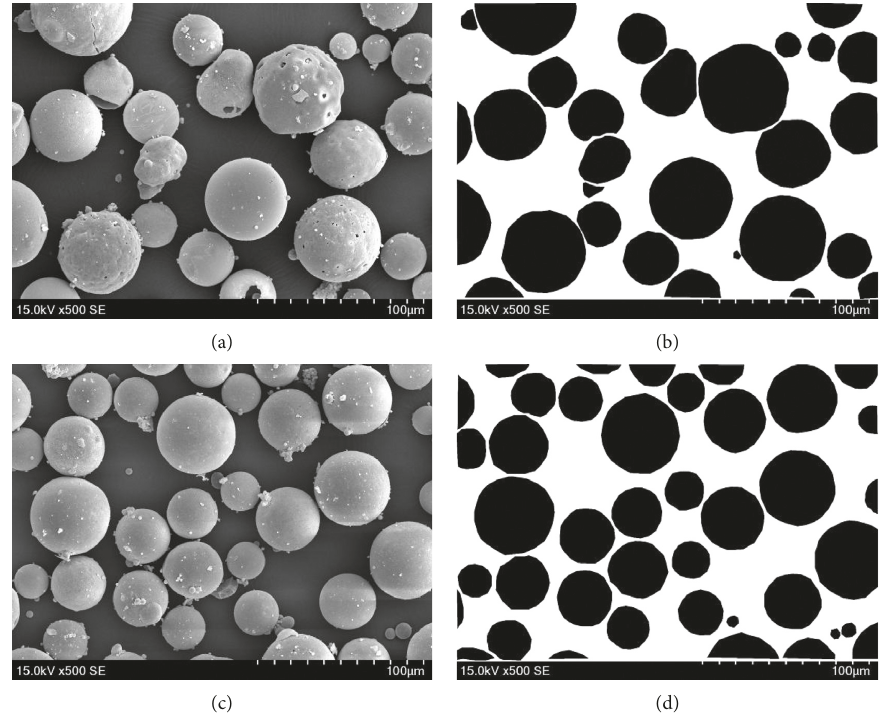
Figure 2: SEM microphotographs of the cenospheres before and after flotation. (a) Original image of F0. (b) Binarization processing image of F0. (c) Original image of F2. (d) Binarization processing image of F2.